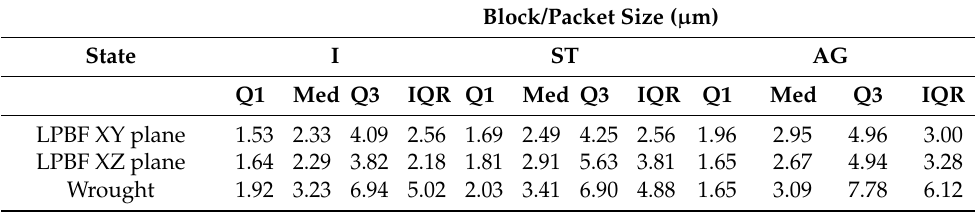
Figure 11. Boxplot of the block/packet size distribution of the LPBF and wrought alloys in different processing states. Table 7. Interquartile range box data from block/packet size